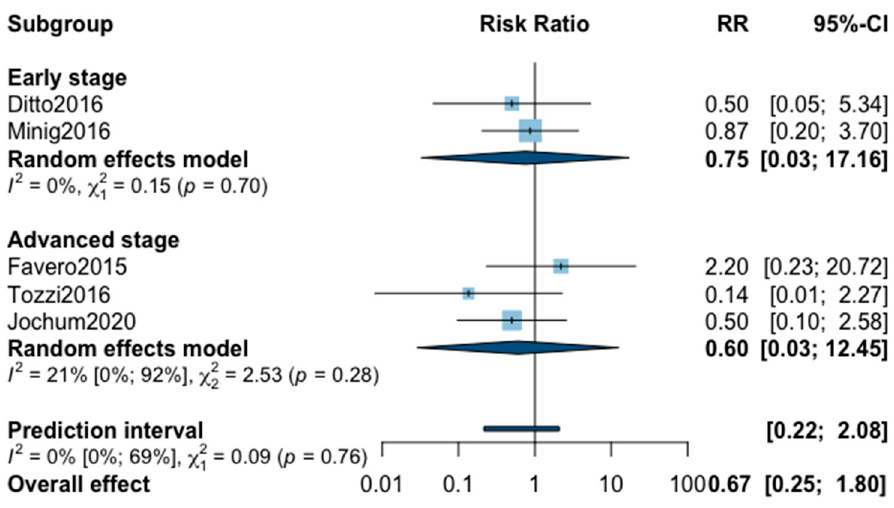
Figure A8. Meta-analysis for postoperative complications grade ≥ Figure A8. Meta ‐ analysis for postoperative complications grade ≥ 3 . Figure A8. Meta ‐ analysis for postoperative complications grade ≥ 3 .